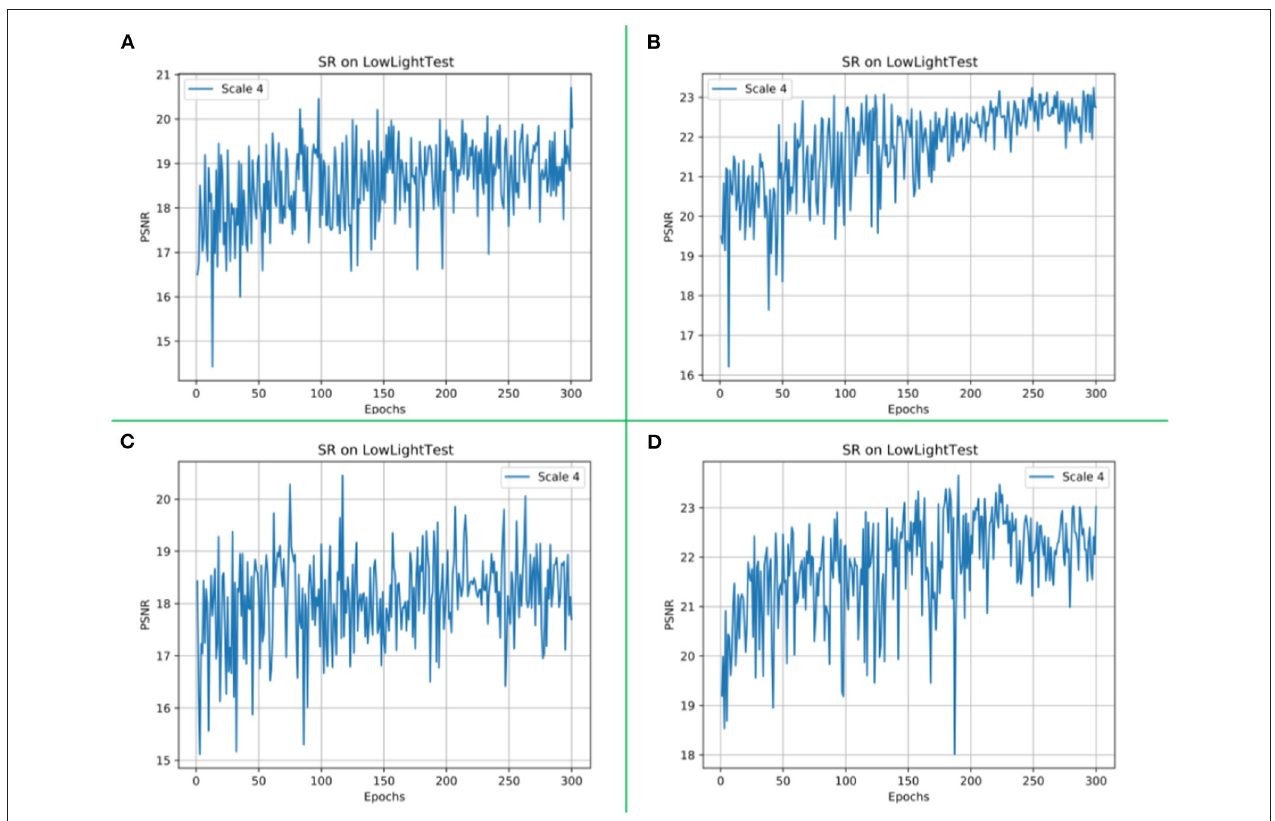
FIGURE 12 | The PSNR values of the validation dataset at different epochs during training. Experiment 1 is shown as (A) in this figure. Experiment 2 is shown as (B) in this figure. Experiment 3 is shown in (C) in this figure. The PSNR value of our proposed method is shown in (D) in this